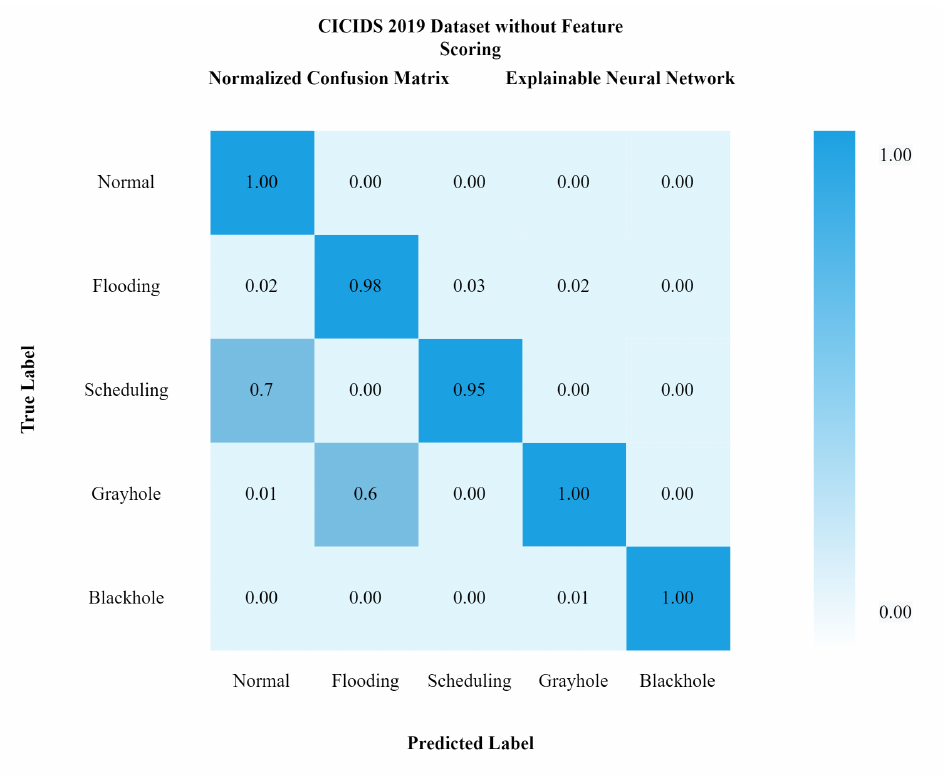
Figure 16. Confusion matrix of xNN for CICIDS2019 without feature